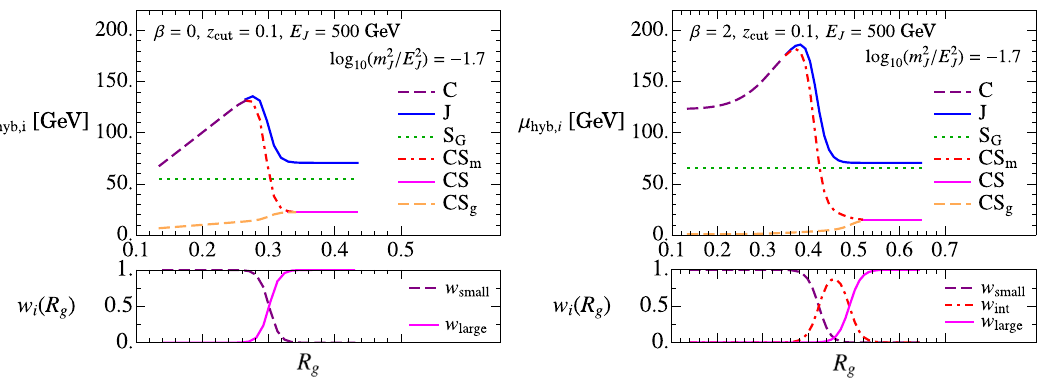
Figure 5 . Hybrid profile scales µ hyb ,i for β = 0 and β = 2 , shown as a function of the groomed radius R g at a fixed jet mass. The bottom panels show the transition functions that give weight to the various regimes. In the left panel we have a situation involving the 2-EFT situation, whereas in the right panel we have a 3-EFT